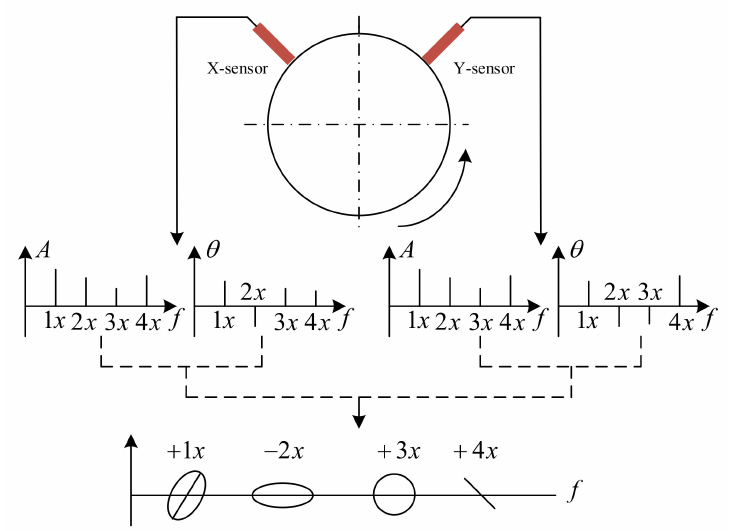
Figure 10. The 2D holospectrum schematic diagram.